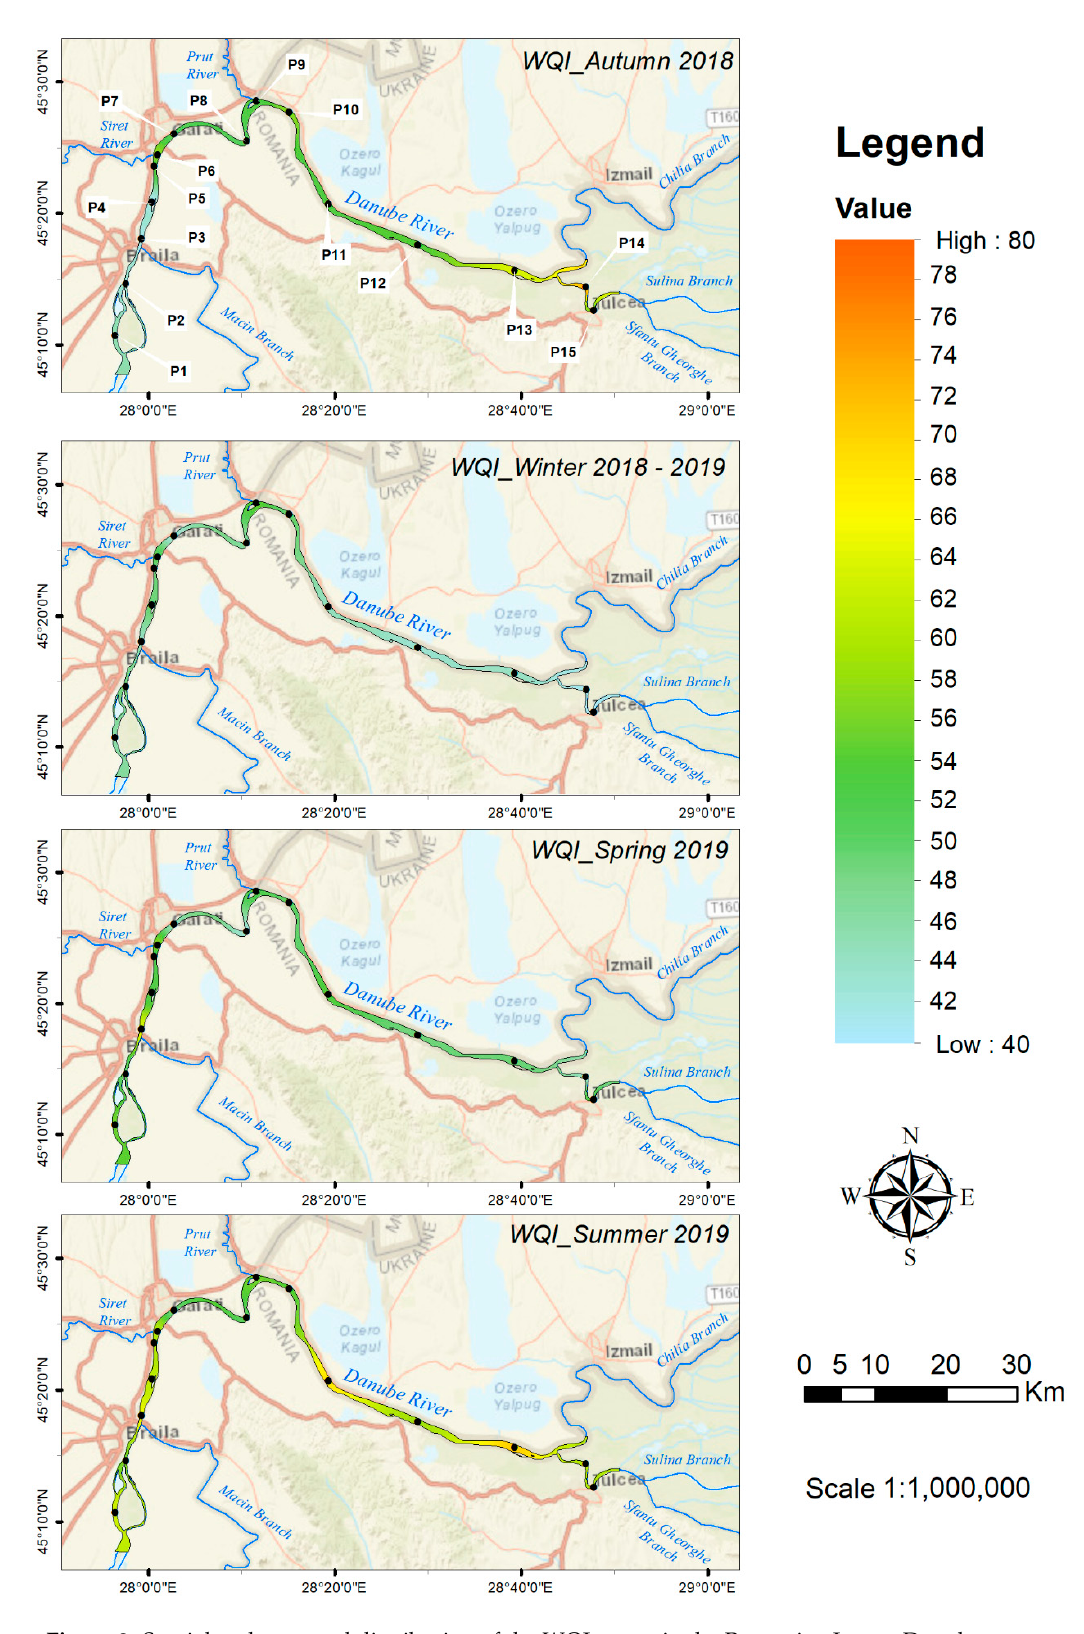
Figure 2. Spatial and temporal distribution of the WQI scores in the Romanian Lower Danube sector recorded during the period autumn 2018–summer 2019.